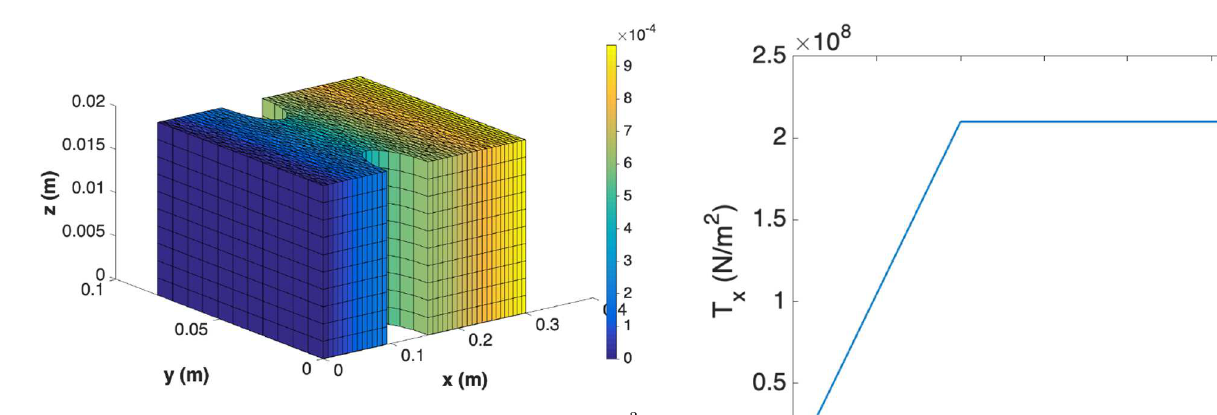
( x = H x ) previously defined in the x -direction), i.e. u ∗ x equation (40).